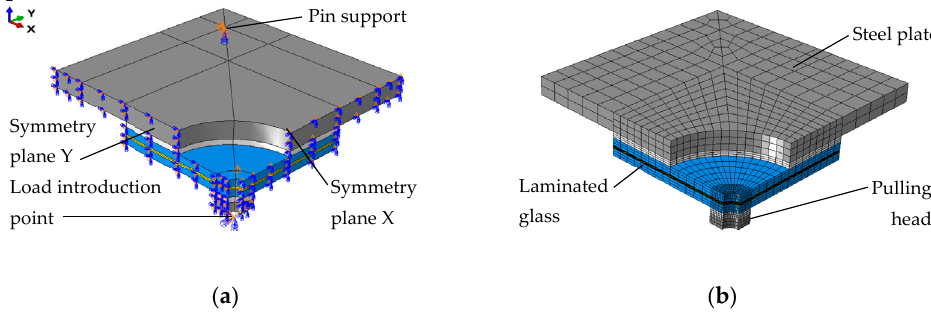
Figure 4. Numerical model: ( a ) boundary conditions; ( b ) mesh pattern.